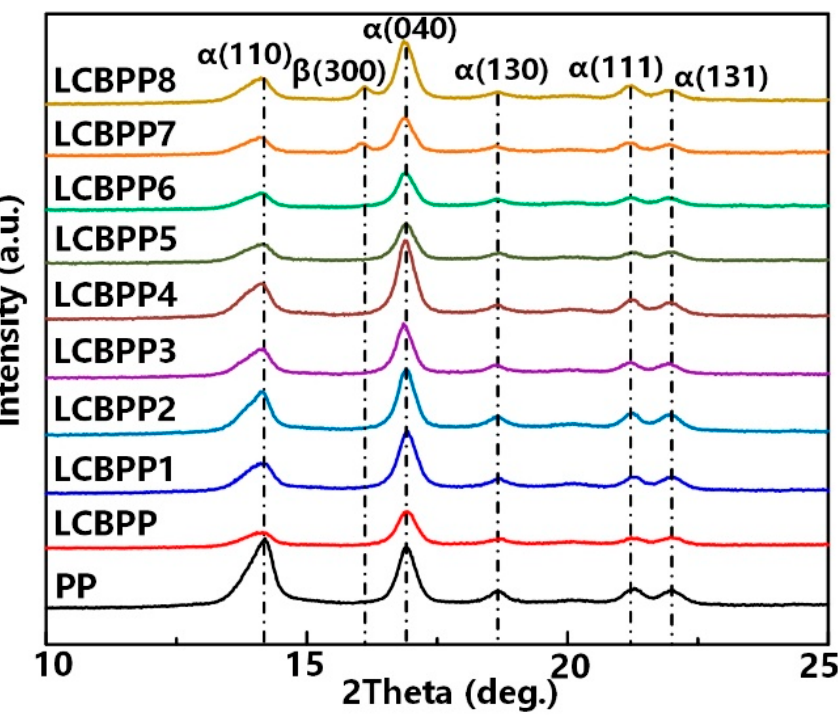
Figure 3. The FTIR characterization of the test samples.